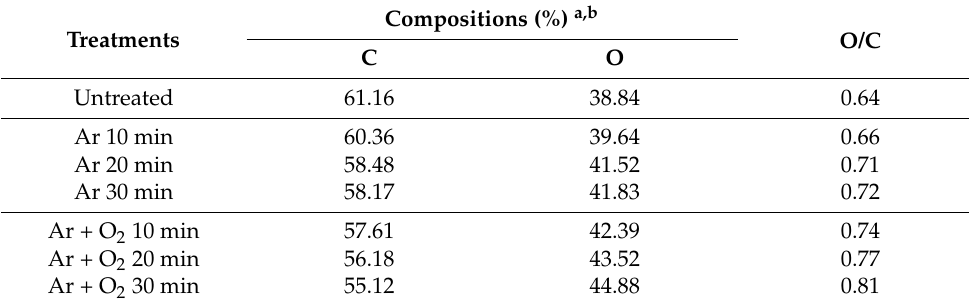
Table 4. Chemical composition of the untreated and treated BFs.